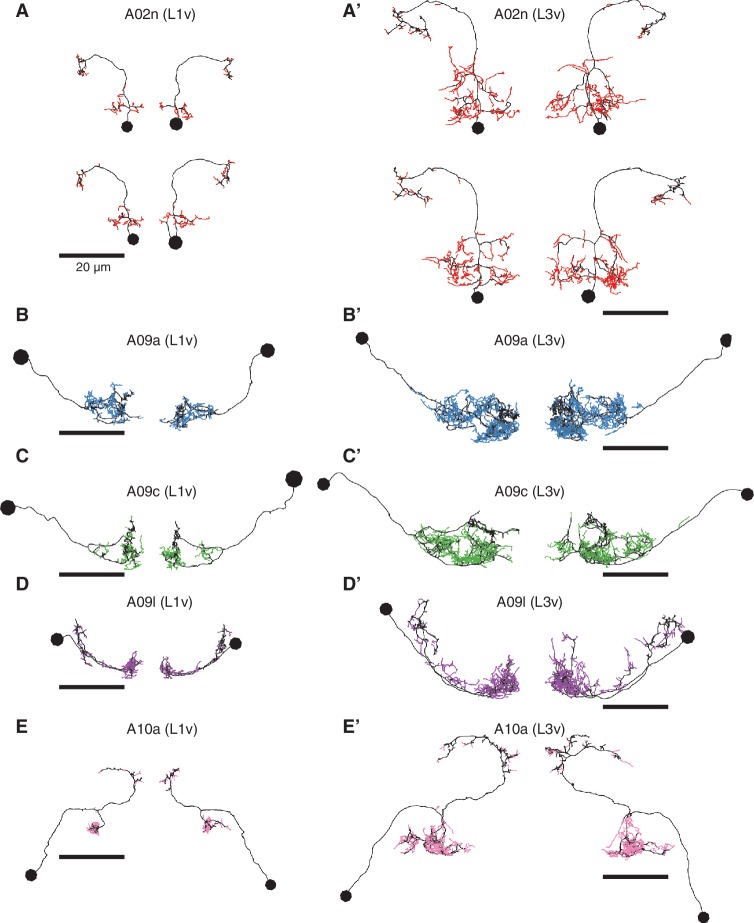
Twig and backbone morphology for all LNs.Backbones are shown in black, twigs with colors. Neurons from the L1v are shown to left (Regular letters), neurons from the L3v to right (Primed letters). Posterior view with dorsal up. Scales are consistent across all figures, scale bars are 20 μm.